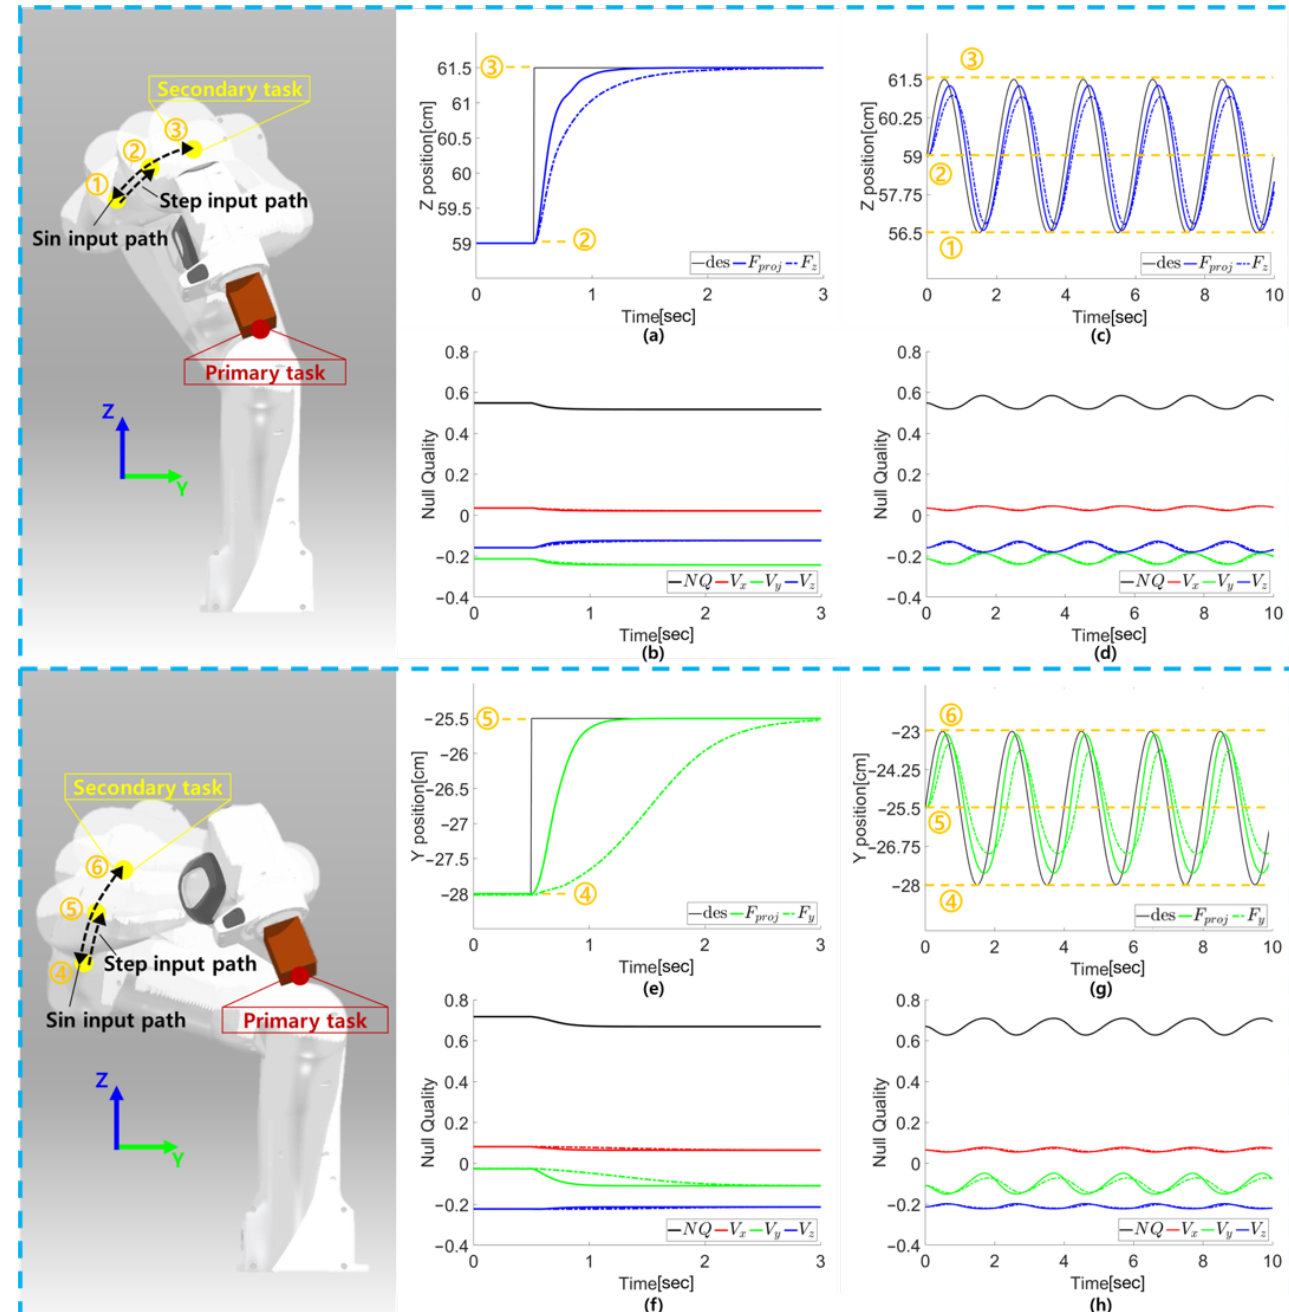
Figure 4. Simulation results with respect to the step and sinusoidal input are shown. The configuration and movement of the secondary task are described in the left side of the figure. ( a – d ) are the results when the secondary task is controlled along the z-axis. ( a , b ) show the response of the robot and the corresponding null space quality when the step input is applied. ( c , d ) show the response of the robot and the corresponding null space quality when the sinusoidal input is applied. When the desired task is in the z direction, the value of V z plays a key role. In this situation, V z is enough to control the robot in the z direction, but the force input projected to V improves the performance. With the step input, the proposed method, which projects the input force into V , decreases the rise time by 51.79% and the settling time by 54.82%. Furthermore, the RMS error has been decreased by 33.94% when the sinusoidal input is applied. ( e – h ) are the results when the secondary task is controlled along the y-axis. In this case, controlling to y direction is difficult because the V y , controllability to y direction, is relatively low. In such a situation, the proposed method is more effective. As a result, the rise time, the settling time, and the RMS error decreased by 73.48%, 72.35%, and 38.97%,